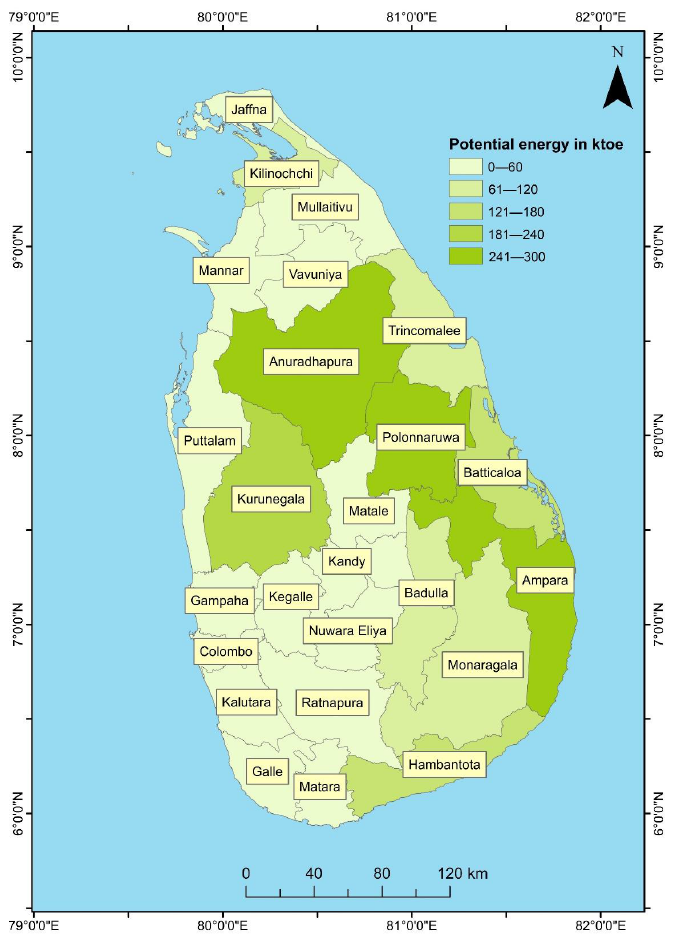
Figure 6. Geographic distribution of the energy potential.